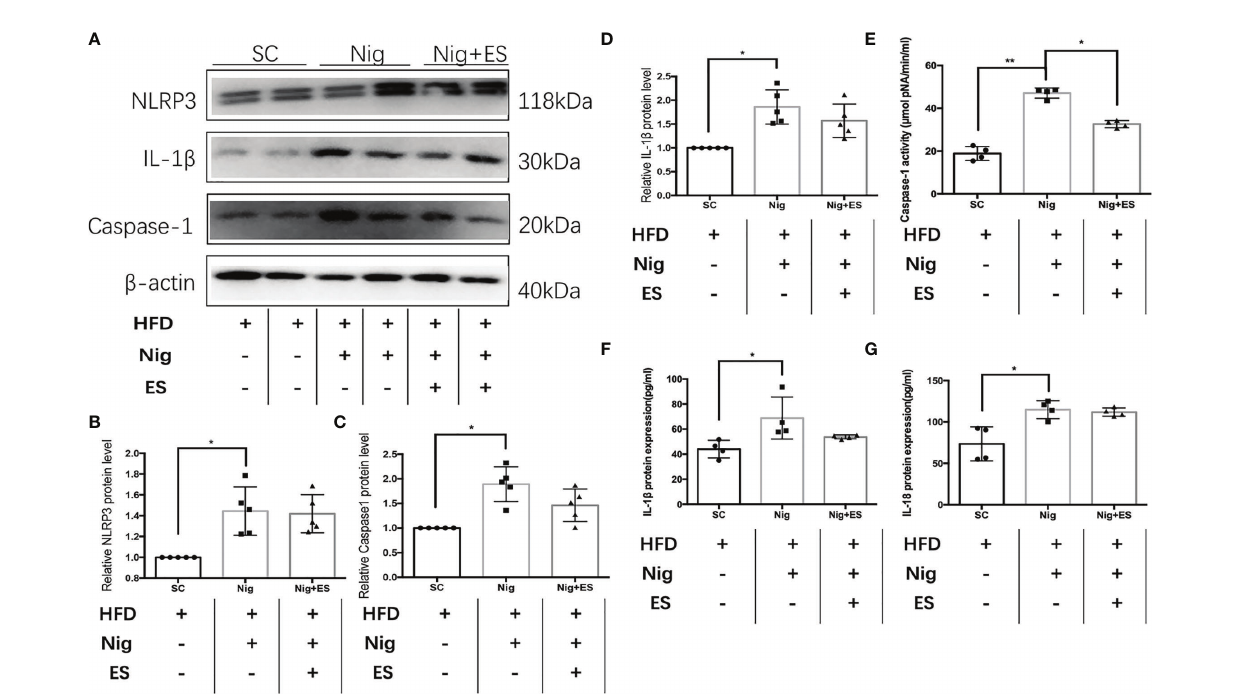
FIGURE 6 | The NLRP3 in fl ammasome agonist activated the NLRP3 in fl ammasome in the ES group. (A) Immunoblot image showing NLRP3, caspase-1, and IL-1 b in the SC group, Nig group, and Nig+ES group. (B) Relative NLRP3 protein expression in eWAT (n = 5, * P < 0.05). (C) Relative caspase-1 protein expression in eWAT (n = 5, * P < 0.05). (D) Relative IL-1 b protein expression in eWAT (n = 5, * P < 0.05). (E) Relative caspase-1 activity in eWAT (n = 4, ** P < 0.01, * P < 0.05). (F) Relative IL-18 expression in serum (n = 4, * P < 0.05). (G) Relative IL-1 b expression in serum (n = 4, * P <